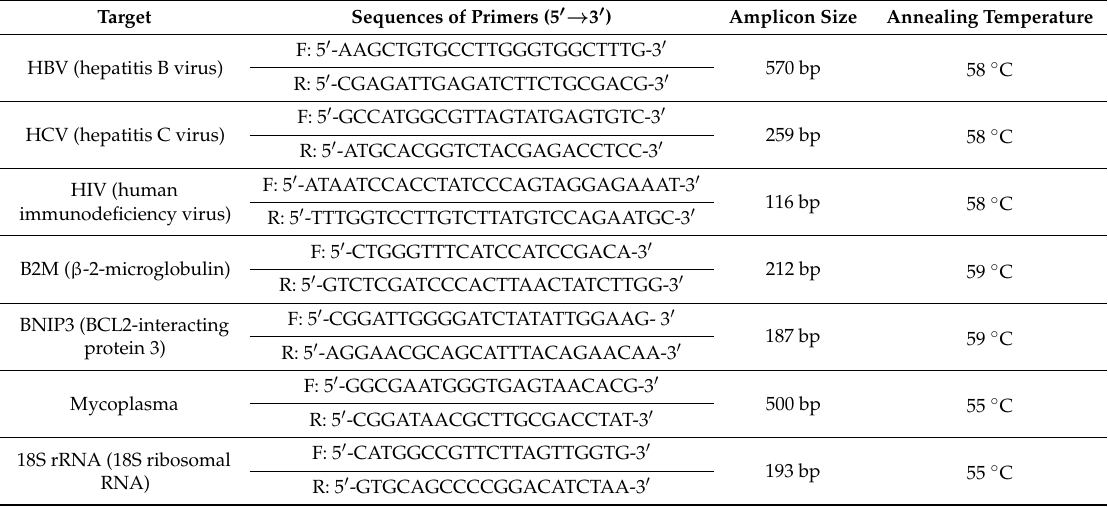
Table 3. Primers and conditions used for viruses and mycoplasma detection by PCR; F—forward primer, R—reverse